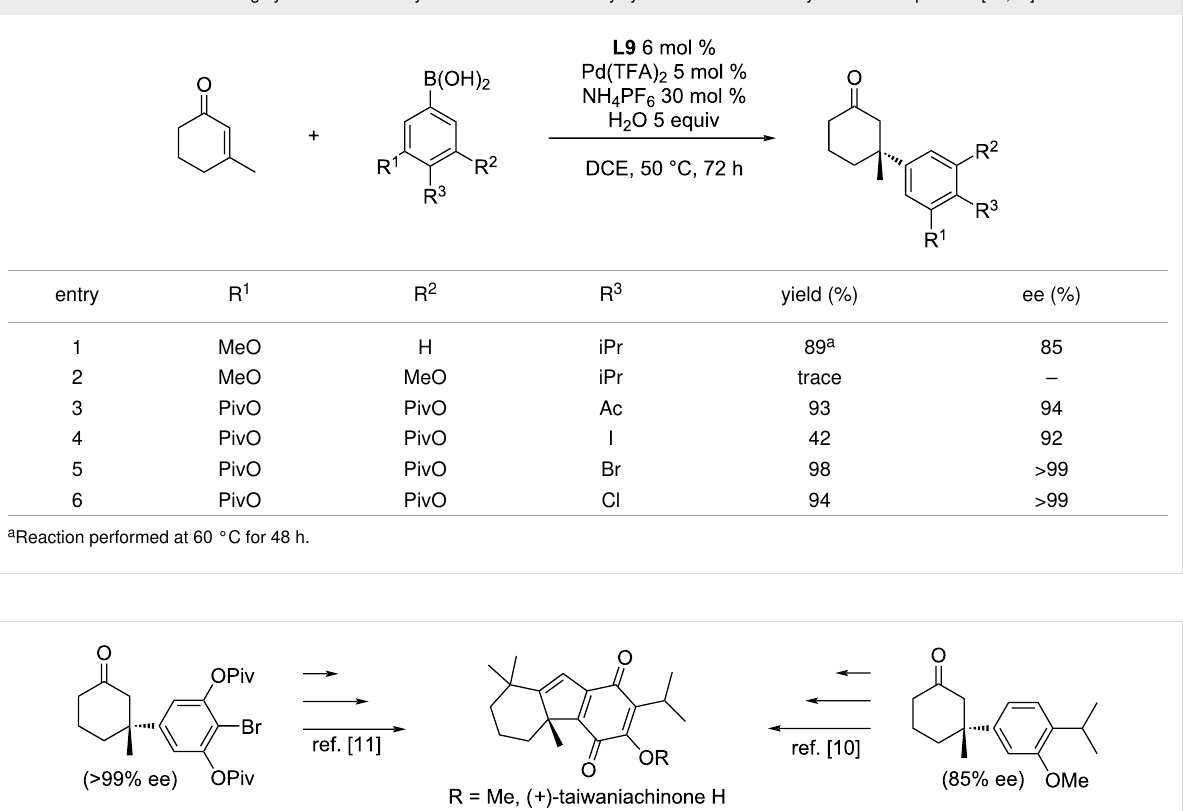
Table 25: Addition of various highly functionalized arylboronic acids to 3-methylcyclohexanone for the synthesis of terpenoids [10,11].